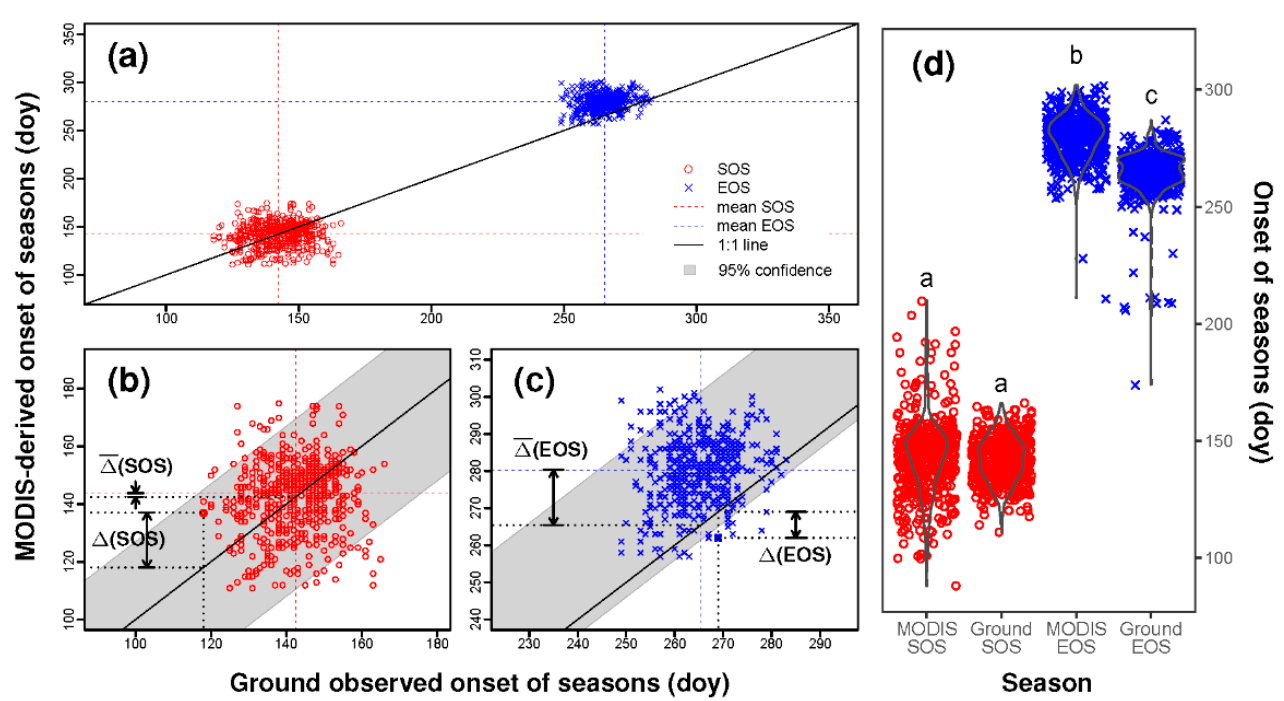
Figure 5. Comparison between the MODIS-derived and the ground-observed onsets of the start (SOS) and end (EOS) of the cropland growing season from 2001 to 2010 in Northeast China. ( a ) Scatterplot with the 1:1 line and the mean MODIS-derived versus ground-observed dates; ( b , c ) Enlargement showing the MODIS-ground difference in SOS and EOS at a given station ( ∆ SOS and ∆ EOS) and the mean difference ( ∆ SOS and ∆ EOS); ( d ) Violin plots showing the data distribution of the MODIS-derived against the ground-observed SOS and EOS. Different letters above the violin plots indicate a significant difference ( p < 0.001).